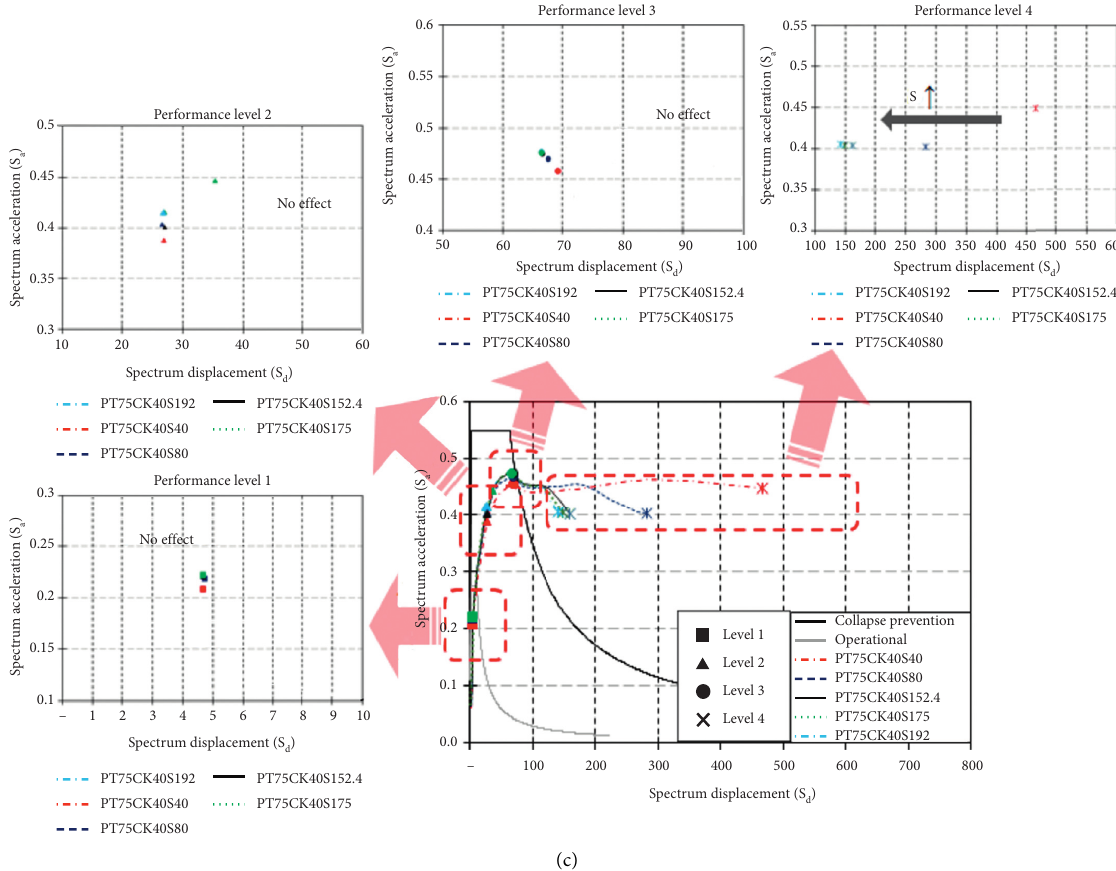
Figure 16: Response spectrum analysis. (a) Prestress. (b) Concrete strength. (c) Spacing of transverse